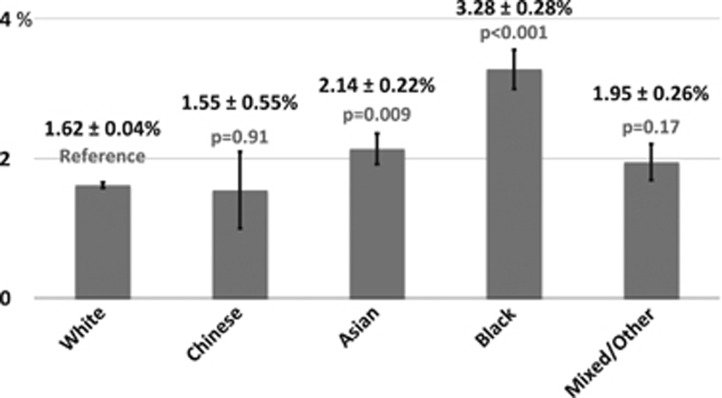
Reported rates of glaucoma by ethnicity (%±SE). The rates of self-reported glaucoma is greatest in Black (P<0.001) and Asian (P=0.009) participants.